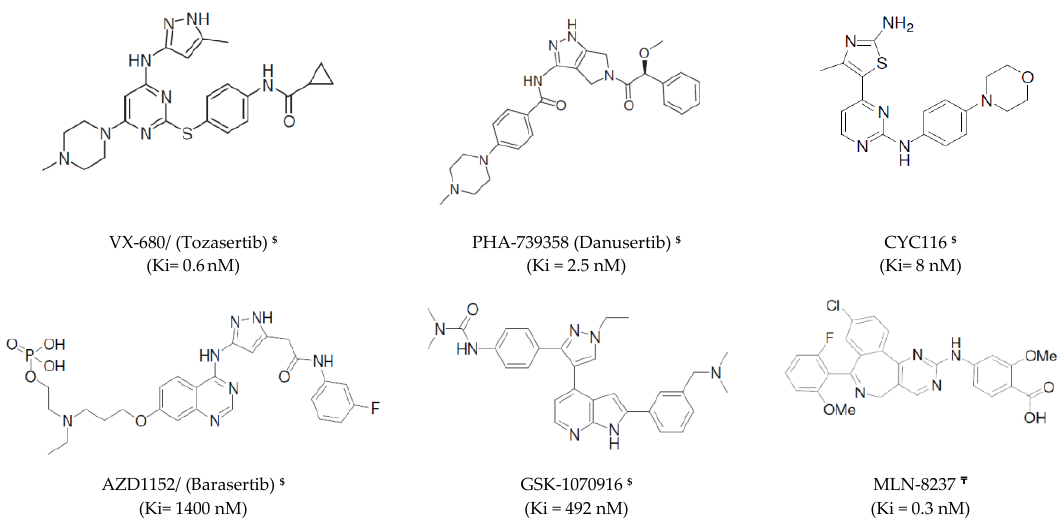
Figure 1. The chemical structures of Aurora-A kinase inhibitors studied via clinical trials. $ Pan-selective to Aurora kinases A, B & C. ₸ Selective to Aurora- A kinase [39 – 50].